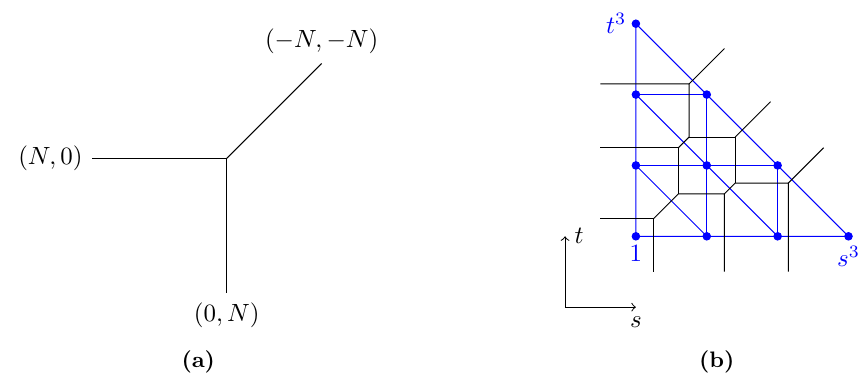
Figure 1. Left: the 5-brane junction describing the T N SCFTs with charge assignments in ingoing convention. Right: brane web and grid diagram for a mass deformation of the T 3 theory. Some examples of the monomials associated to the grid points are